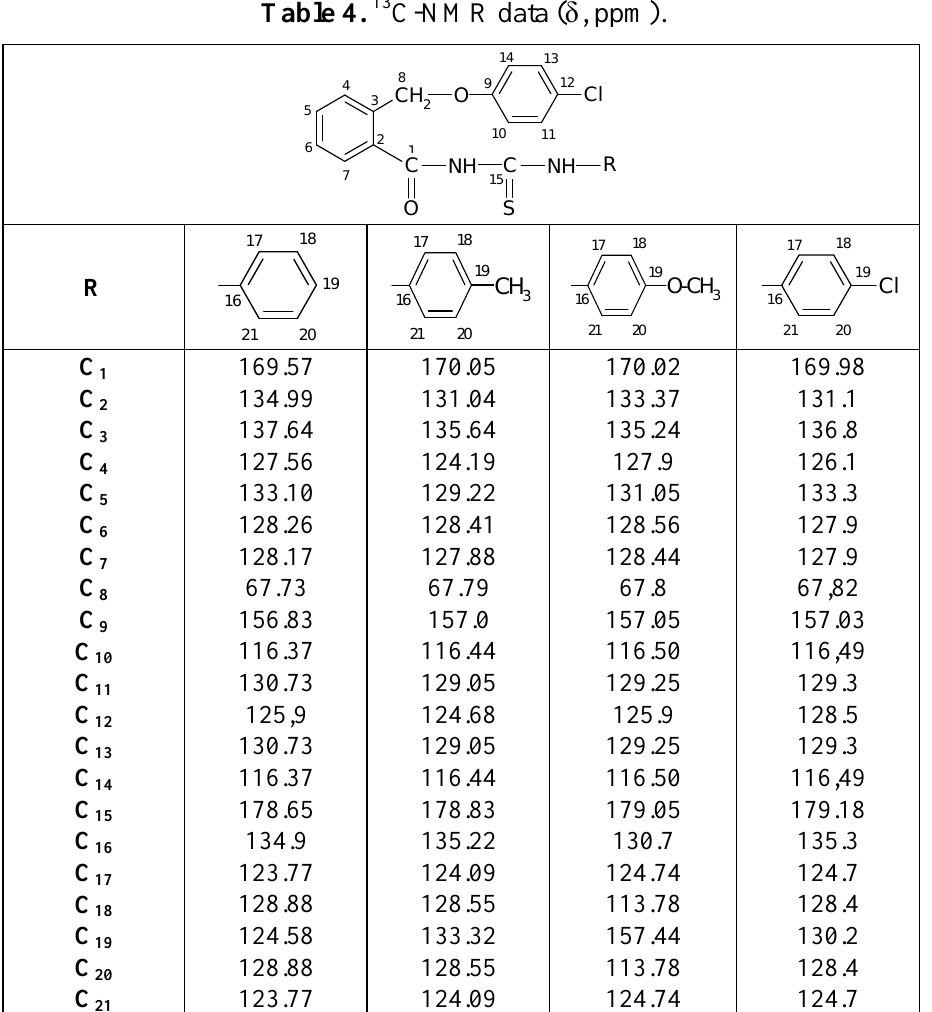
Table 4. 13 C-NMR data ( δ ,